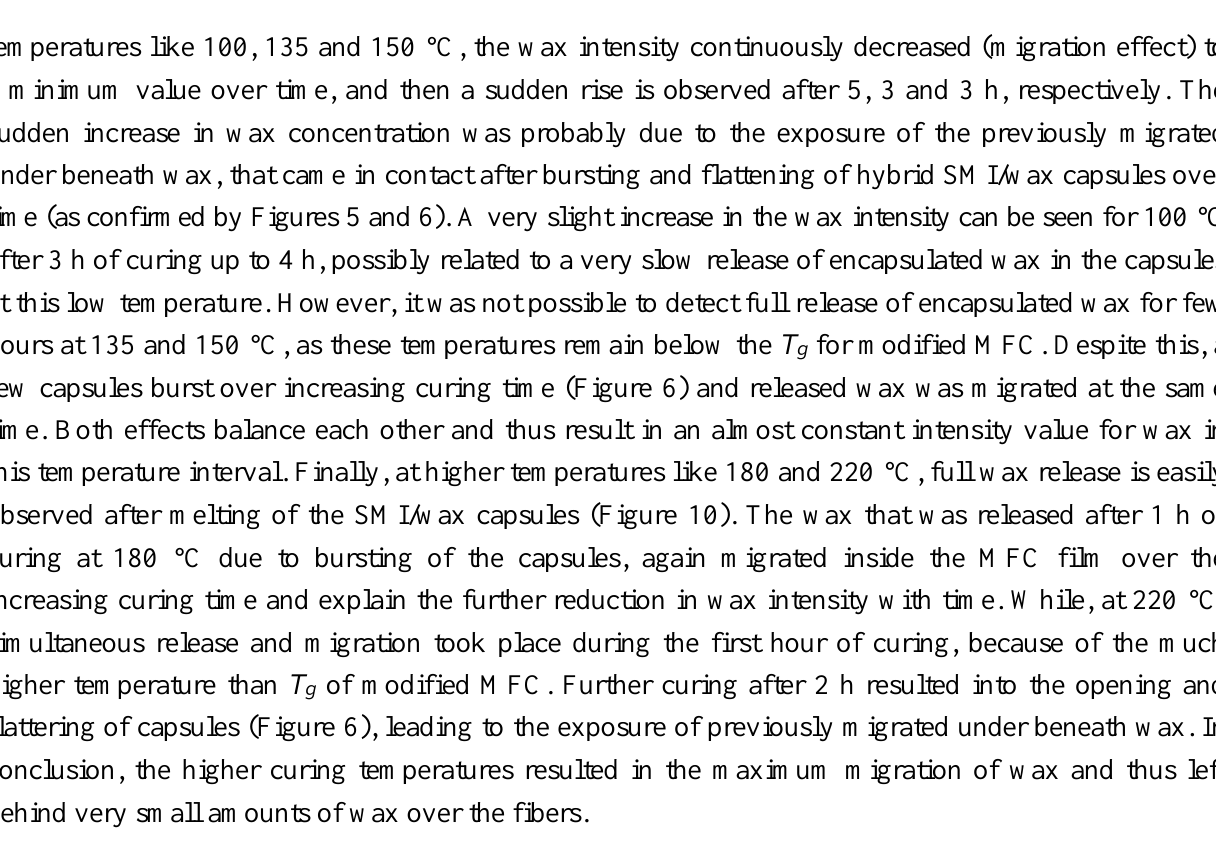
Figure 10. Normalized wax intensity at 2917 cm −1 for non-cured (RT) and cured modified MFC films after curing at different temperatures and